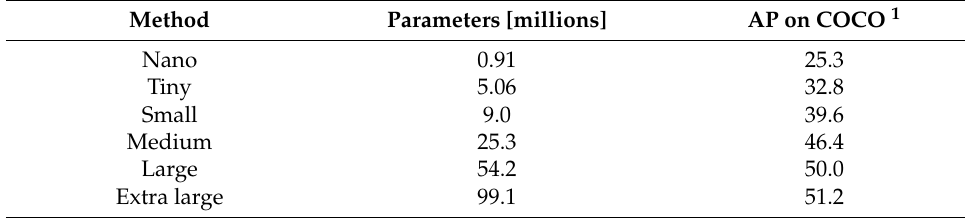
Table 2. Methods of YOLOX.